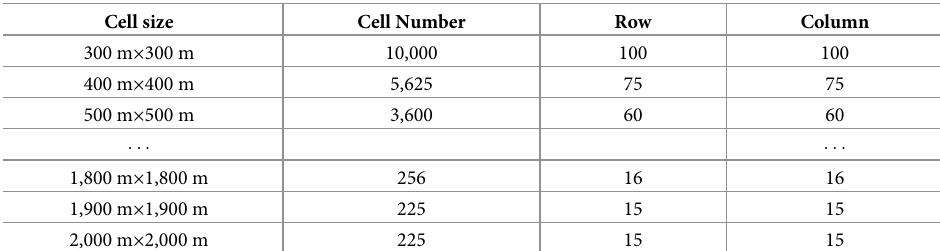
Table 1. Cell sizes and the corresponding basic